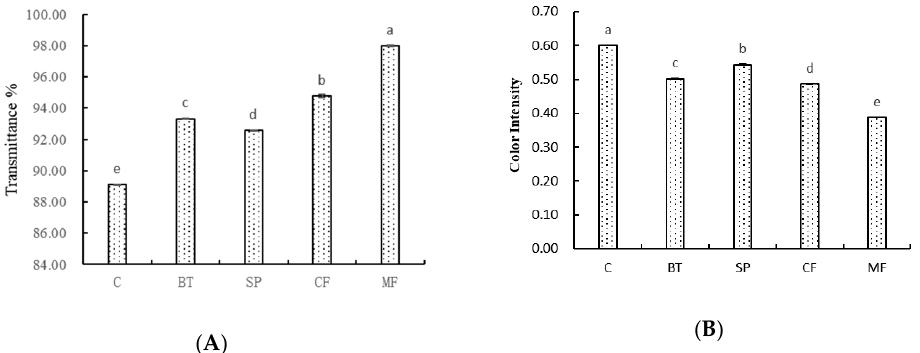
Figure 1. Change of ( A ) light transmittance and ( B ) color intensity in wine samples with di ff erent treatments. Di ff erent letters represent significant di ff erences at a significant level of 0.05. Table 1. Basic physicochemical indexes of wine samples processed under di ff erent clarification process.